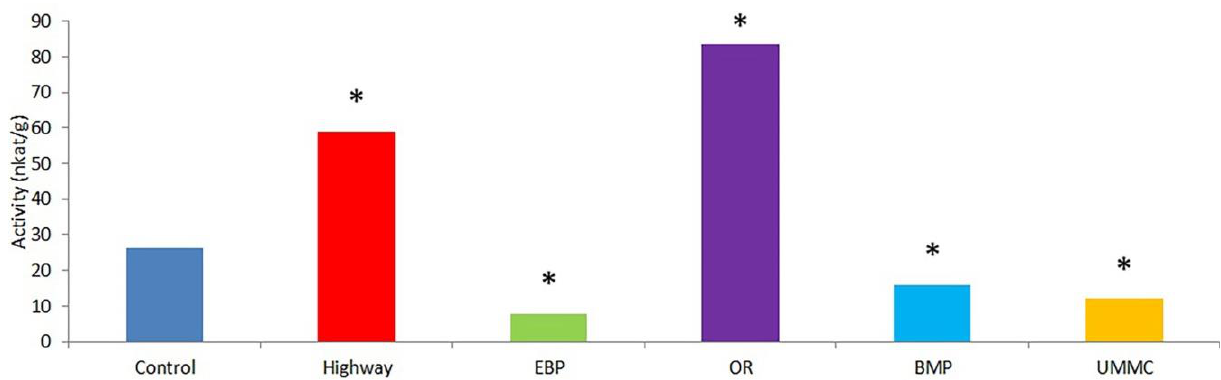
Figure 9. Catalase activity in coltsfoot from studied areas. *—statistically significant difference between control and test group ( p ≤ 0.05).